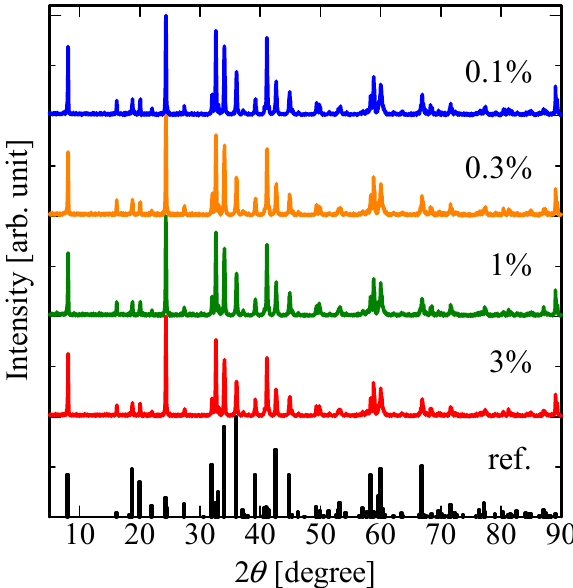
Figure 2. XRD patterns of LaMgAl 11 O 19 :Nd.